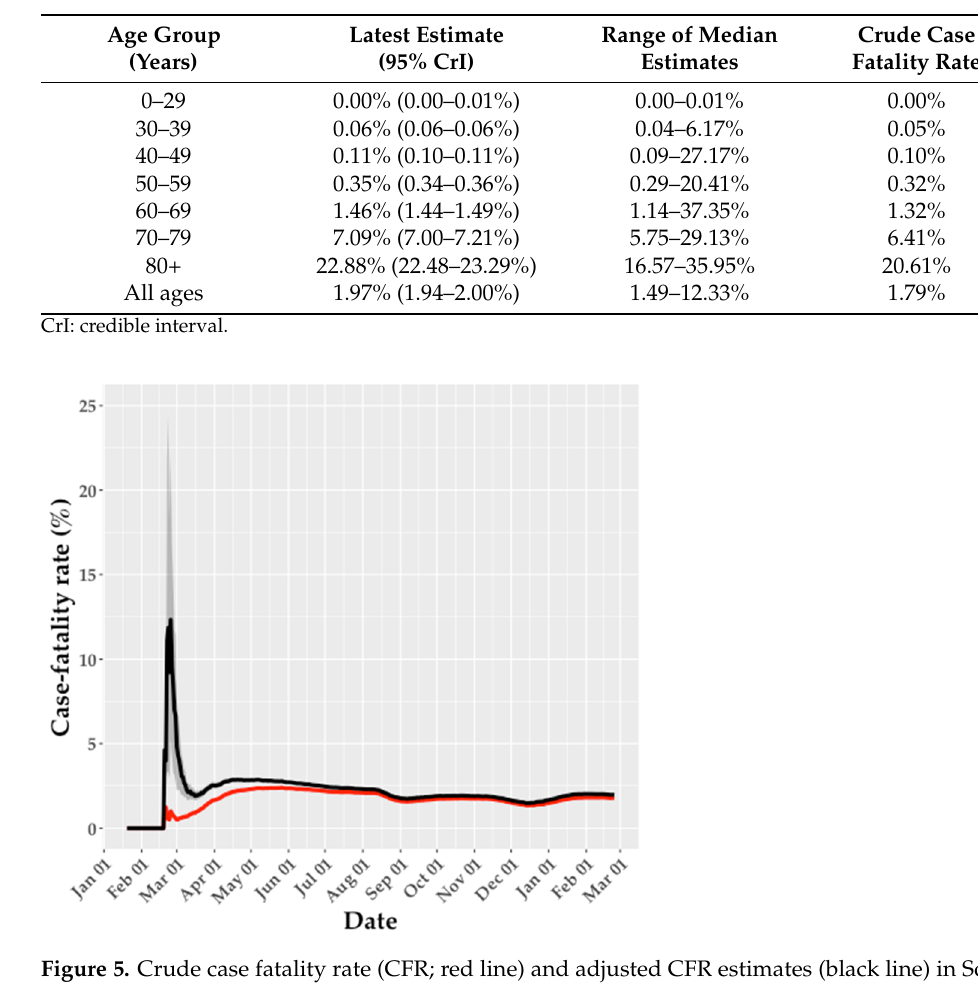
Table 1. Summary results of cumulative time-delay-adjusted COVID-19 case fatality rates according to age group in South Korea (23 February 2021).